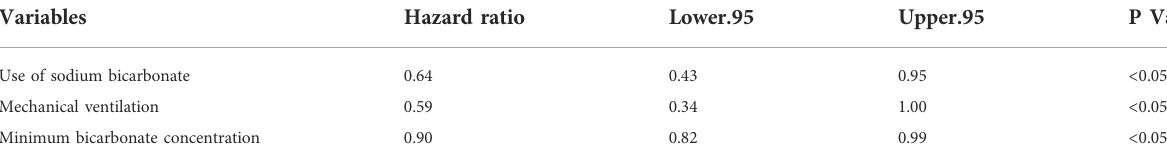
TABLE 4 Cox regression model after propensity score matching for predicting ICU mortality in patients with sepsis and acute moderate metabolic acidosis.